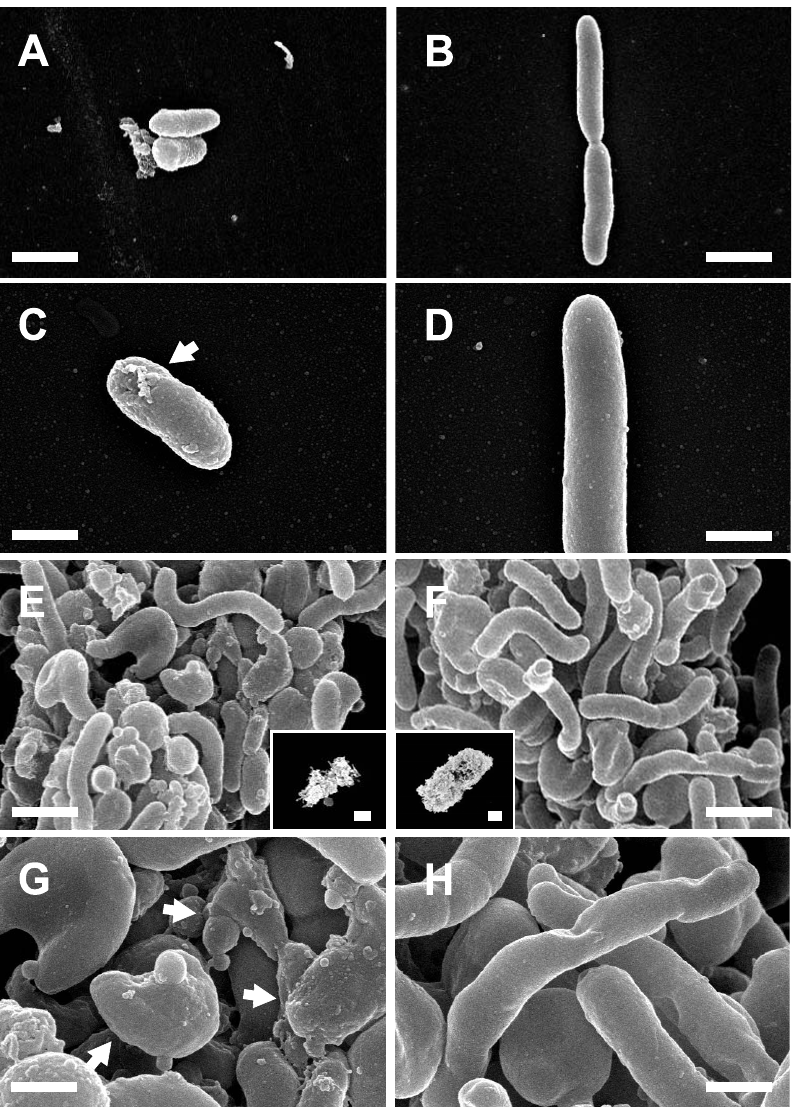
Figure 6. Scanning electron microscopy (SEM). SEM analysis was performed to investigate the photocatalysis-induced deformation of bacterial cells. SEM images of B. cenocepacia cells (strains P2: A–D and BC14: E–H) with (A, C, E, G) or without (B, D, F, H) photocatalysis were taken. Arrows in C and G indicate the cellular deformations. Inserts in E and F are the respective low magnification views of biofilm-like bacterial clusters. Scale bars: 5 m m in A, B, E, F; 2.5 m m in C, D, G, H; 10 m m in the insets of E and F.